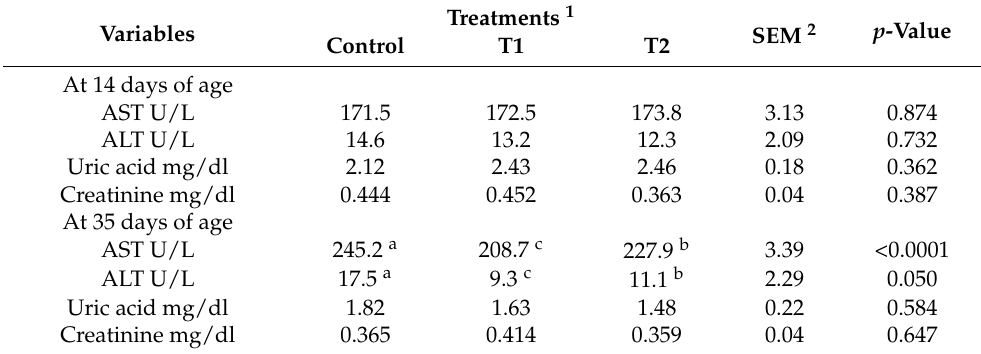
Table 6. Effect of Tribulus Terrestris (TT) supplementation on function tests of liver and kidney in broiler